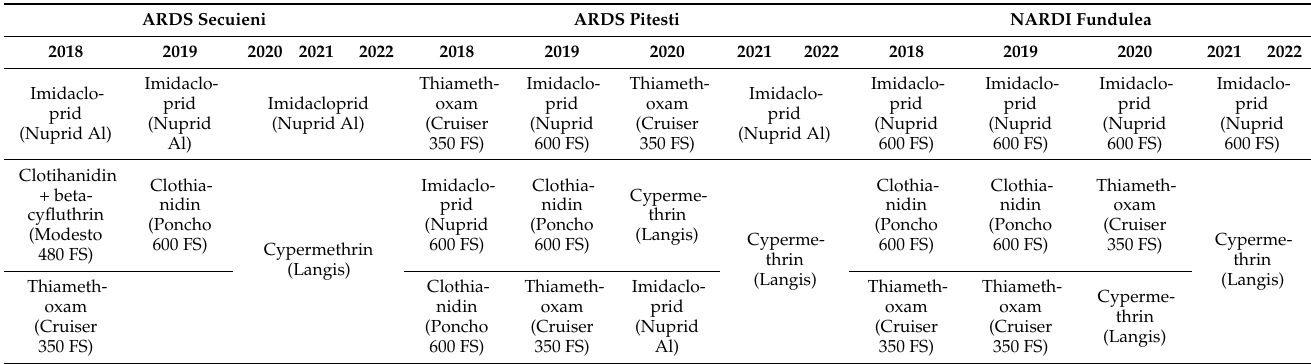
Table 2. Maize experimental variants.